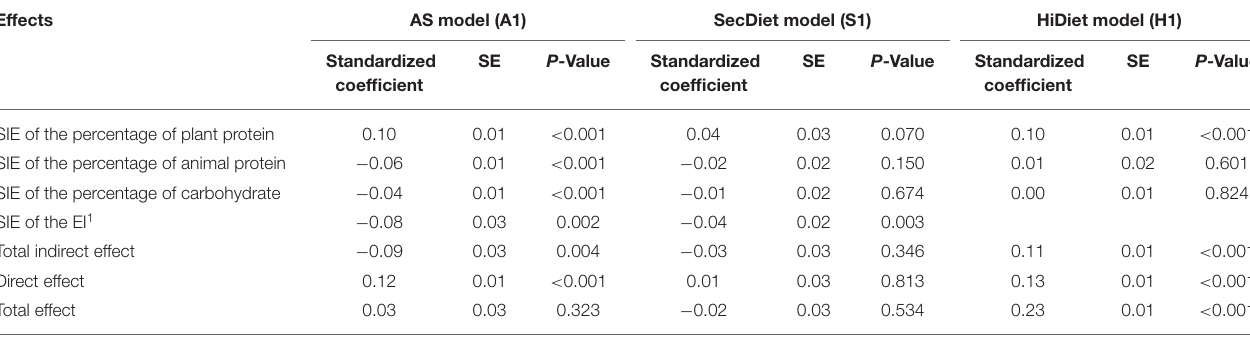
TABLE 2 | Variables of the path analyses between the PDI and the three diet quality scores (AS, SecDiet, and HiDiet) with the plant protein (percentage of total energy intake, %E), animal protein (%E), carbohydrates (%E), and energy intake without alcohol as mediators.